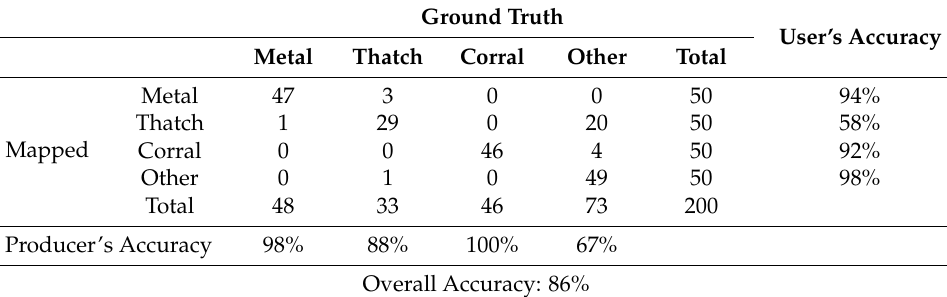
Table 4. Confusion matrix associated with the classification of the 2004